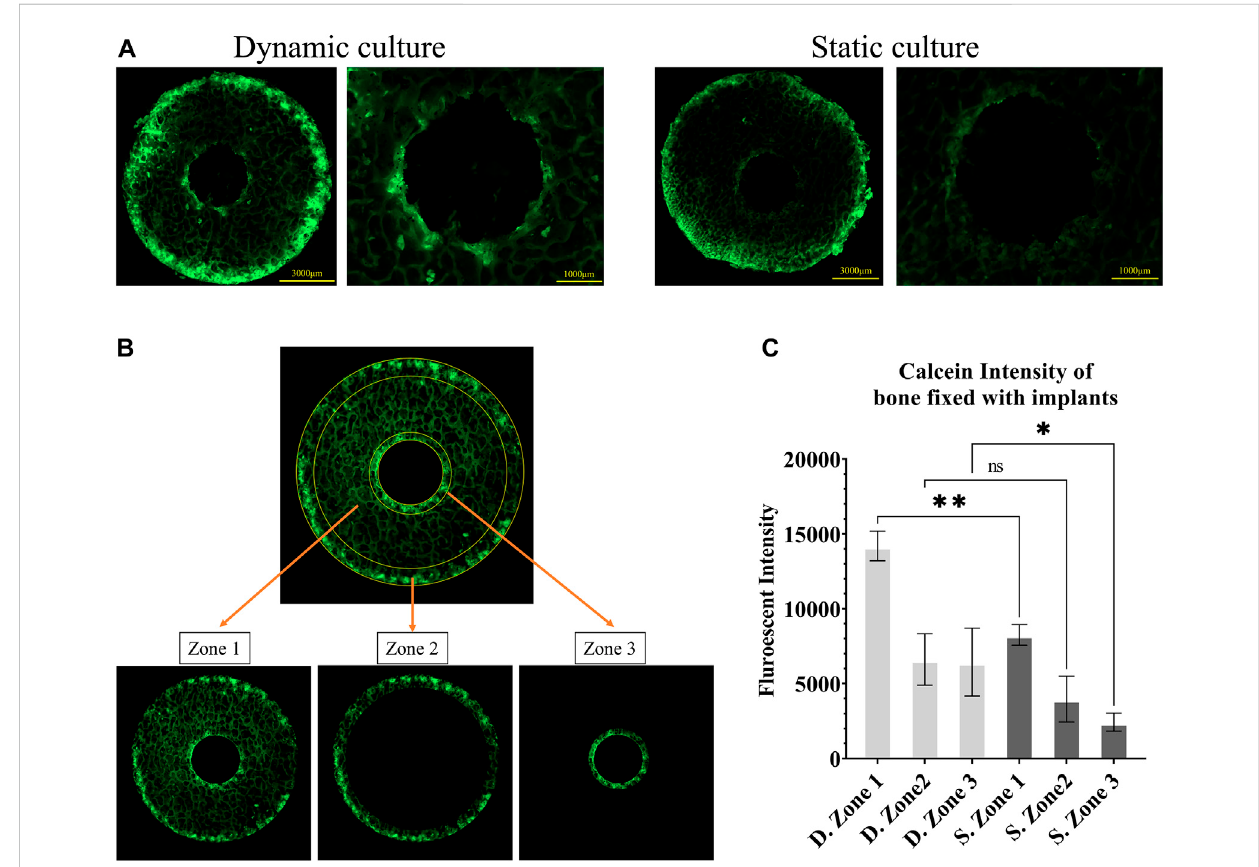
FIGURE 3 Fluorescentimagesofcalceinadministeredontheseventhday (A) Representativeimagesfromstaticanddynamicculturesshowingthetopsurfaces ofthebonecylinders,assessedwithwide fi eldmicroscopyat λ ex495/ λ em515. (B) Thethreeregionsofinterestthatwerequantitivelyanalysed:zone1,the wholebonecylinder,zone2,theouterboneperimeter,andzone3,theboneadjacenttotheimplant. (C) Analysisofcalcein fl uorescentintensity,showing mineralisation accumulation, comparing these 3 zones in static and dynamic culture samples. Values are means of n = 3 (±SD); * p < 0.05, ** p < 0.01, *** p <